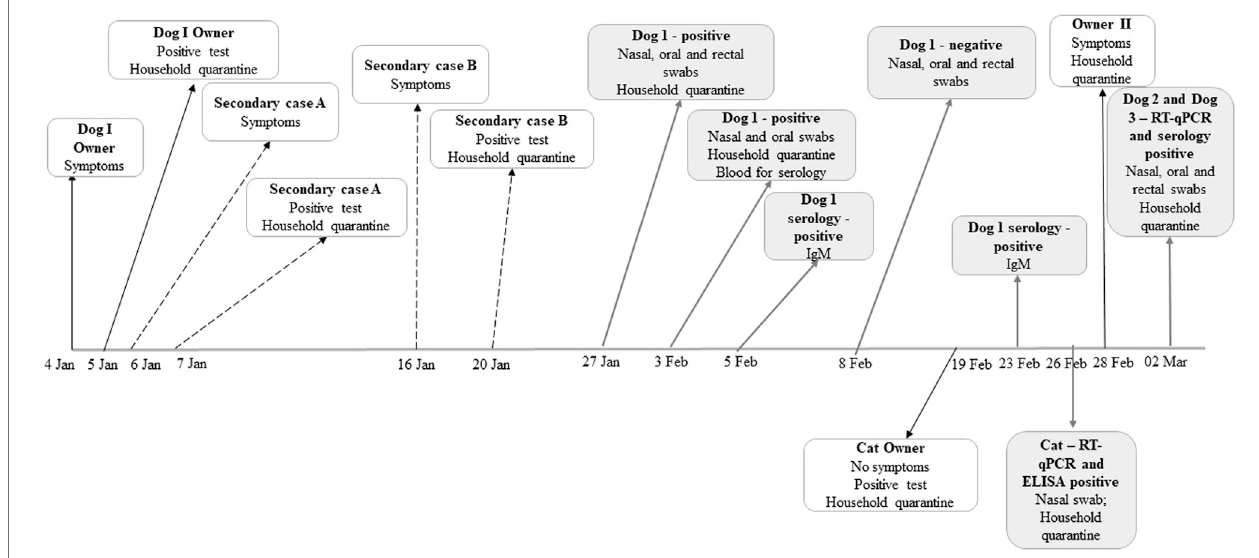
FIGURE 1 | A timeline of events in the human, dog and cat SARS-CoV-2 infection cases that were analyzed in this study.